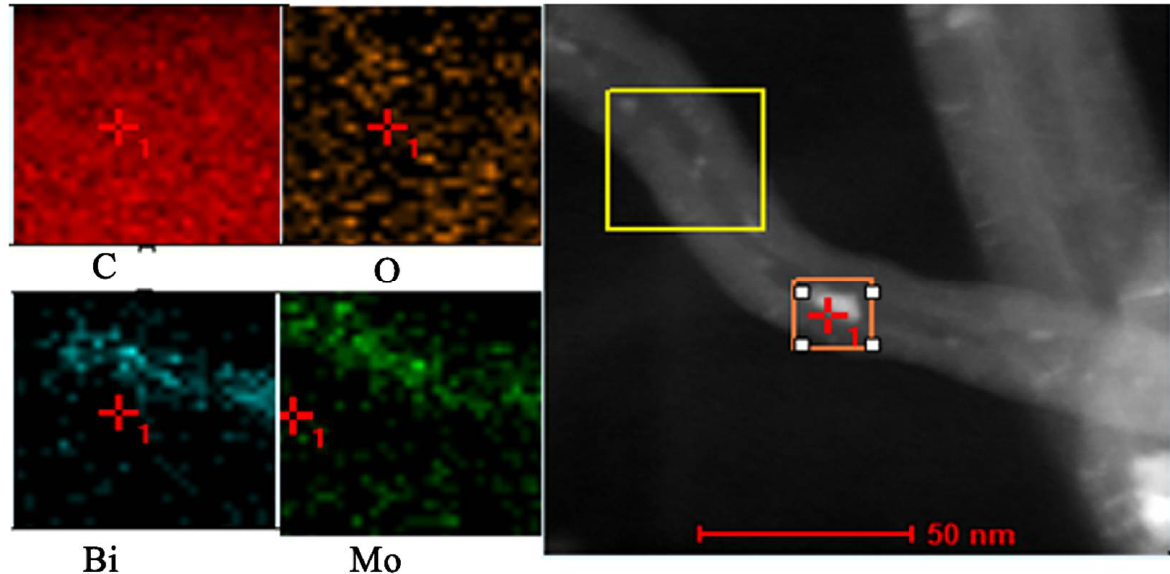
Figure 1. STEM images and elemental mapping of the elements O, C, Mo, and Bi of the 0.018 (BiMo)/CNTs catalyst.